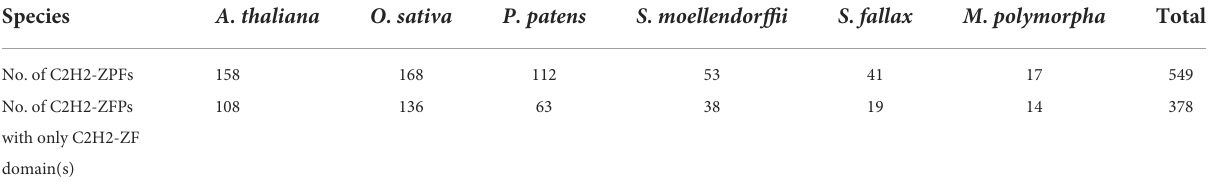
TABLE 1 Overview and classification of C2H2-ZFPs in the representatives of land plant lineages (including statistics of C2H2-ZFPs with only C2H2-ZF domain(s) in each